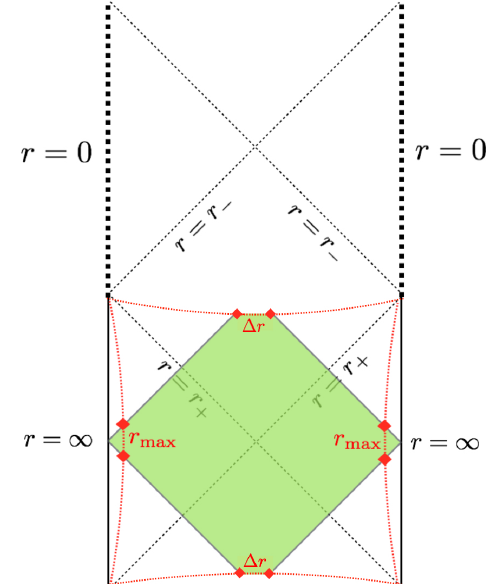
Figure 14. The WDW patch with the alternative regularization scheme, where the future and past tips are cut off and replaced with a regularization surface at r = ∆ r . This introduces four new joints that are shown in the figure as red